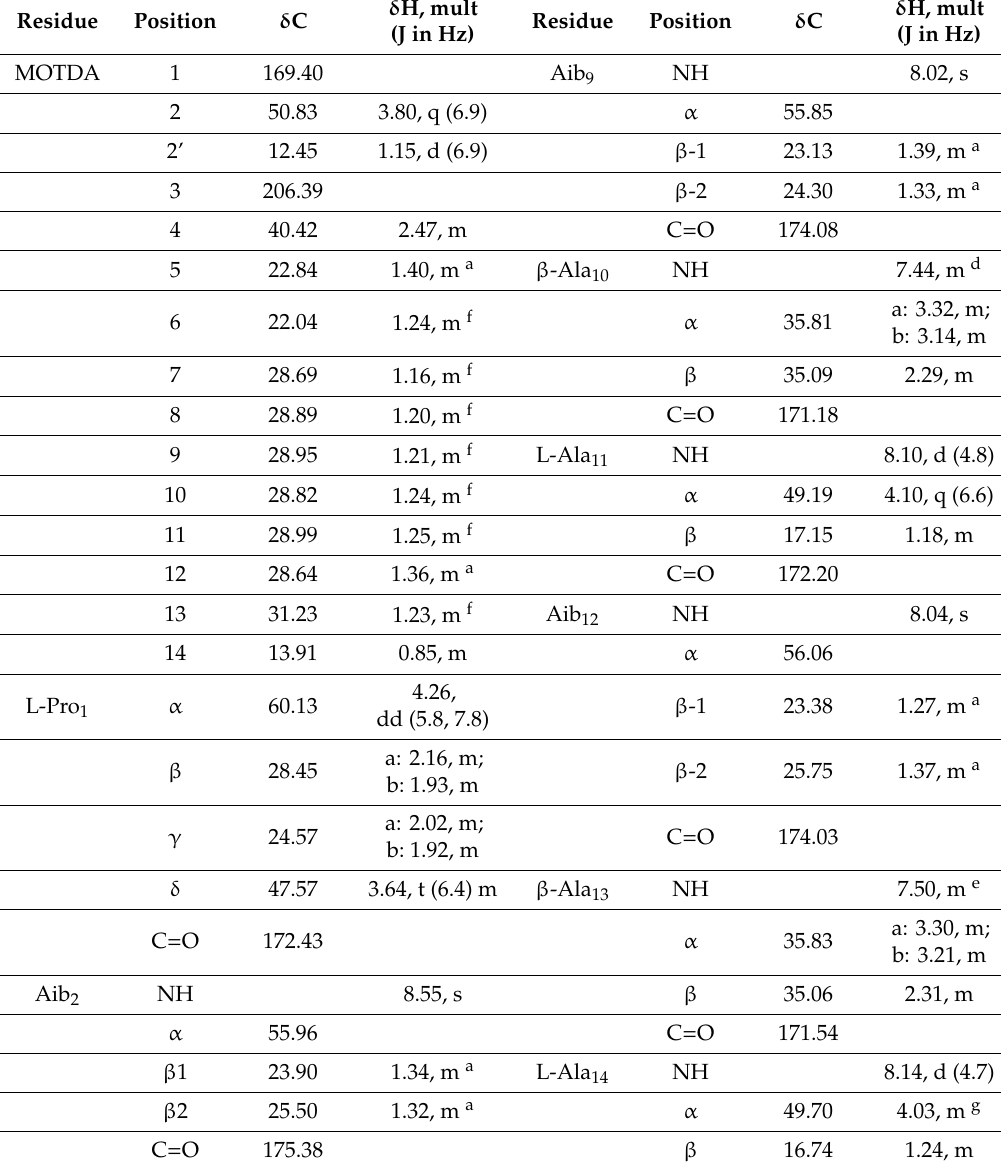
Figure 3. HRMS for sphaerostilbellin A ( 1).